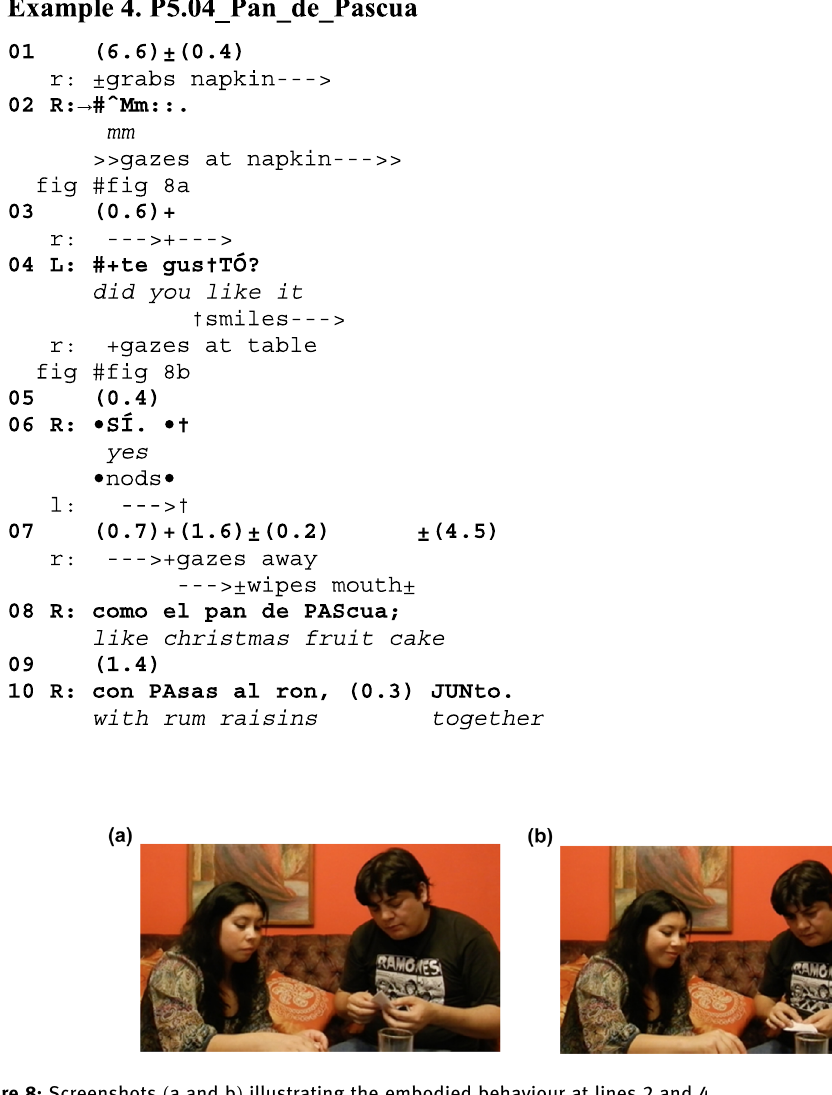
Figure 8: Screenshots ( a and b ) illustrating the embodied behaviour at lines 2 and